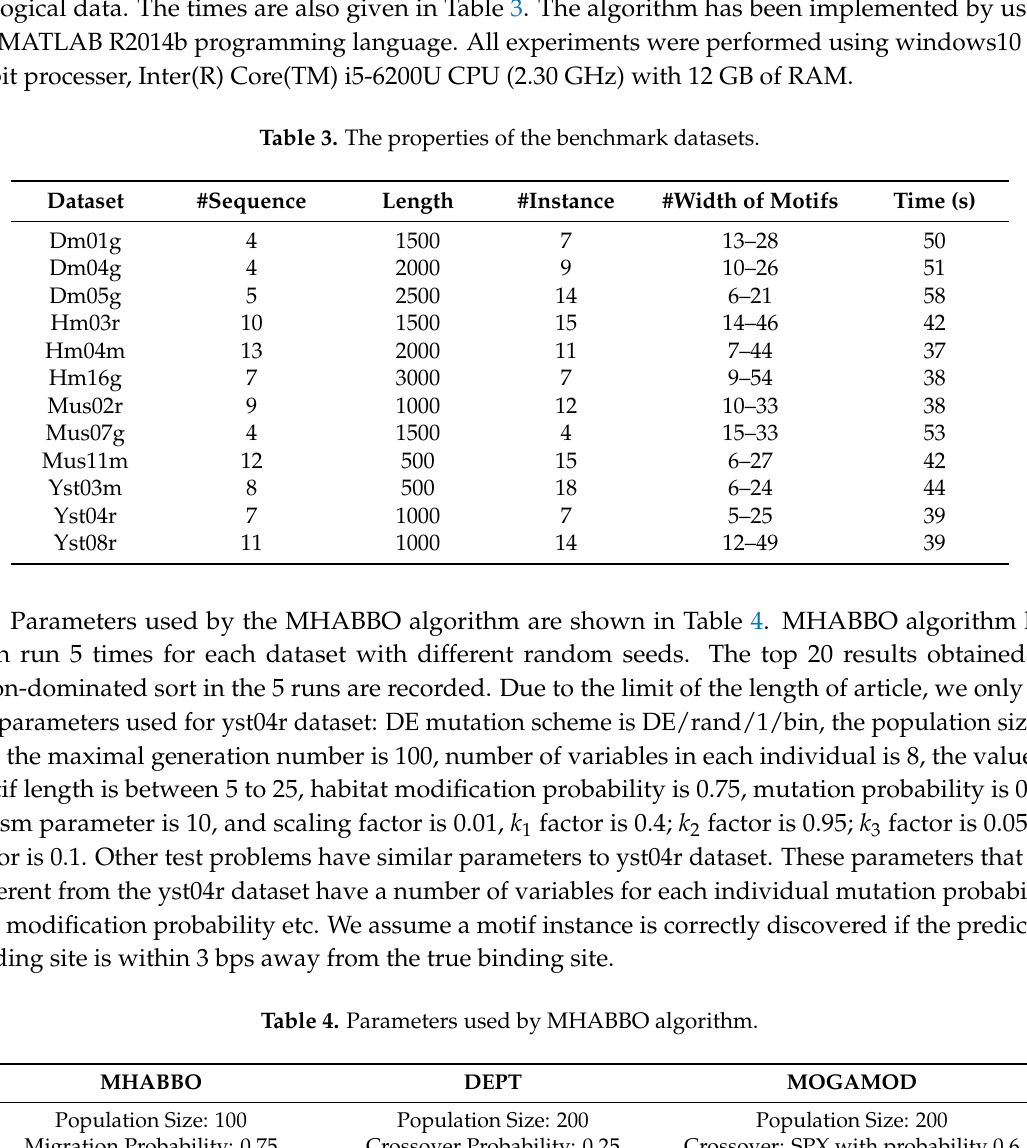
Table 4. Parameters used by MHABBO algorithm.